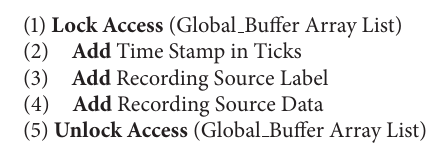
Algorithm 1: Proposed collecting data thread.